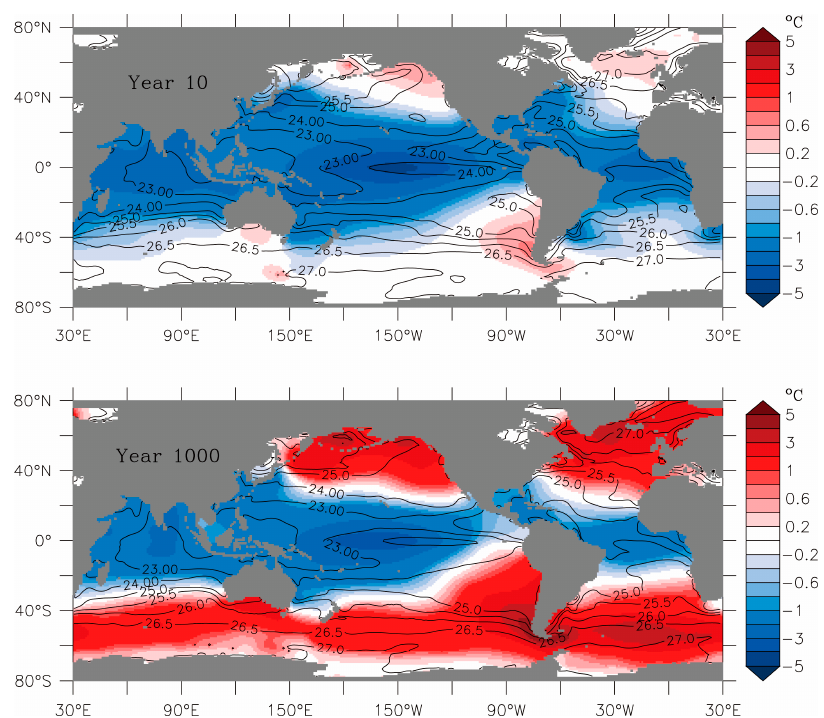
Figure 4. Temperature anomaly δ T (°C) between the control ( CTL ) and an OTEC perturbation ( W15 ) simulations in the model’s uppermost layer (mid-depth of 5 m) 10 years ( upper ) and 1000 years ( lower ) after OTEC activation. Note that the color scale increment is 0.2°C between − 1.0°C and 1.0°C to bring out the weak warming in the high latitudes after 10 years, and 1.0°C otherwise. Also shown are σ θ contours from CTL .